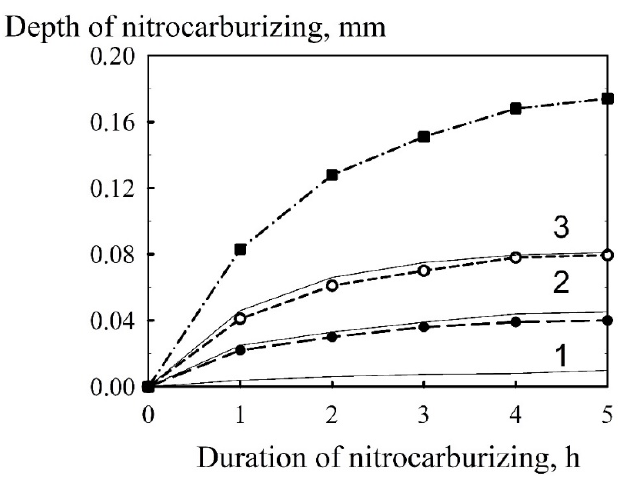
—3 h; (cid:4) —5 h. (cid:35)